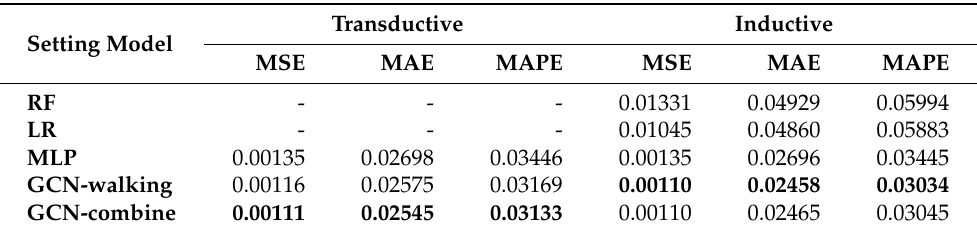
Table 11. Results—Scheme 1 (training/testing/validation set split by area). The best results are shown in bold